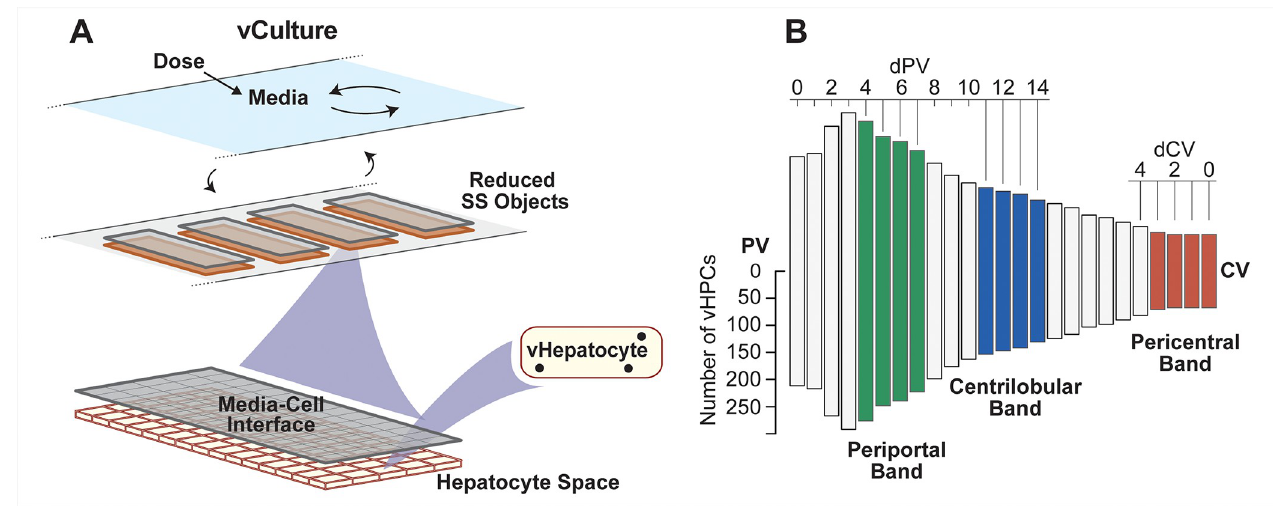
Fig 3. vCulture configuration and relative PV-to-CV vHPC density within vLobules. (A) A vCulture comprises a Media Space plus a single Layer of same- size SS objects (reduced relative to those in Fig 2C). The well-mixed Media Space functions the same as Body. Specification details are listed in S1 Table. (B) Each bar’s height represents the mean number of vHPCs at the indicated vLobule location averaged over 12 Monte Carlo executions. Moving left-to-right from PV (dPV), the first 15 bars correspond to locations at increasing distances from PV along the average PV-to-CV path. Moving right-to-left, the first 10 bars correspond to locations at increasing distances from CV along the average CV-to-PV path. We average measures within the Periportal, Centrilobular, and Pericentral bands to characterize PV-to-CV differences in vCompound Entry and removal rates per vHPC.